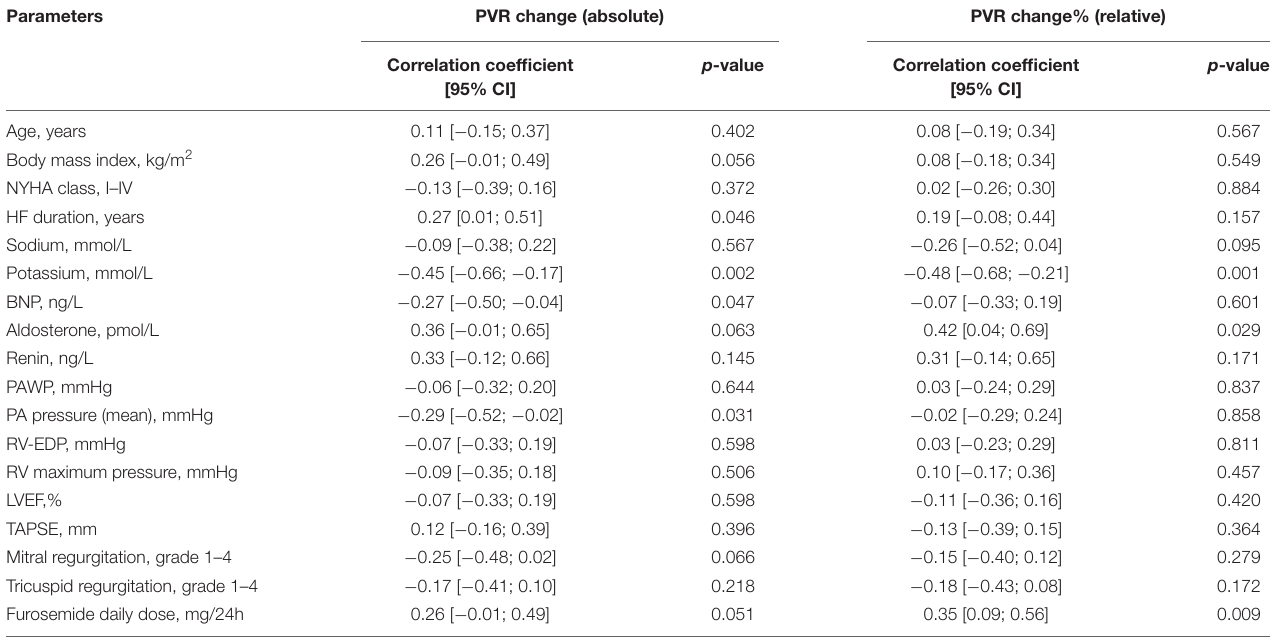
TABLE 3 | Correlation between baseline clinical variables and absolute and relative PVR change after sildenafil. Parameters